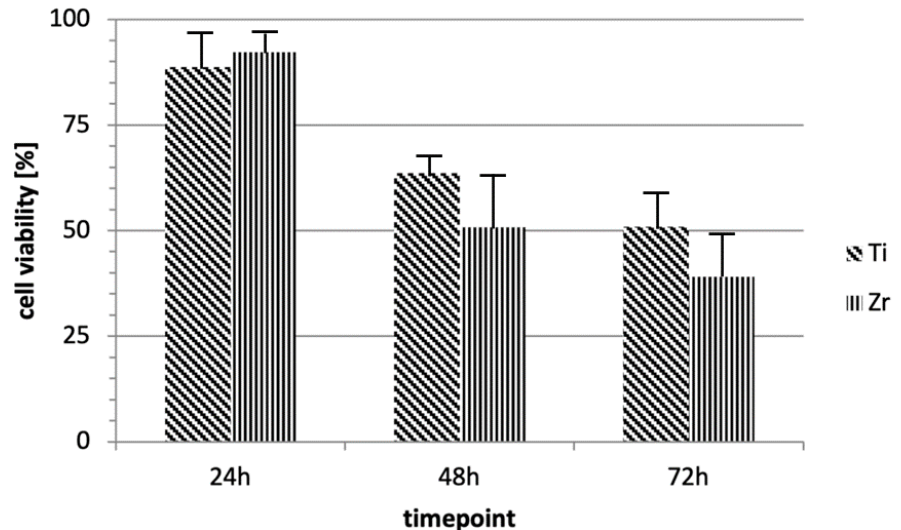
Figure 5. MTT assay. The graph illustrates cell viability of T1 or T2 compared with that of C at different time points (24, 48, and 72 h) of incubation with discs. Each bar represents percentage (mean ± standard deviation) with respect to the control (C).